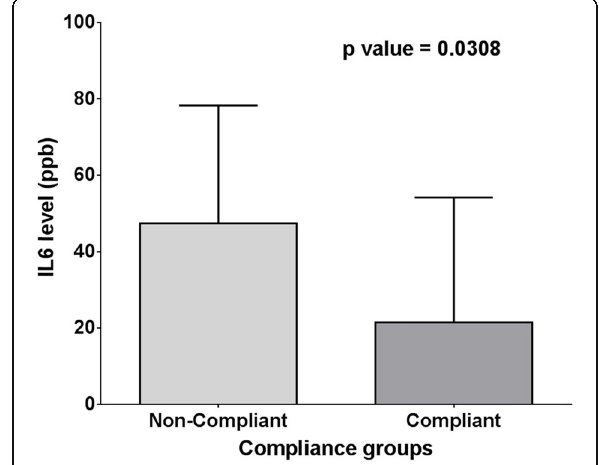
Fig. 8 Mean and SD of IL-6 compliance